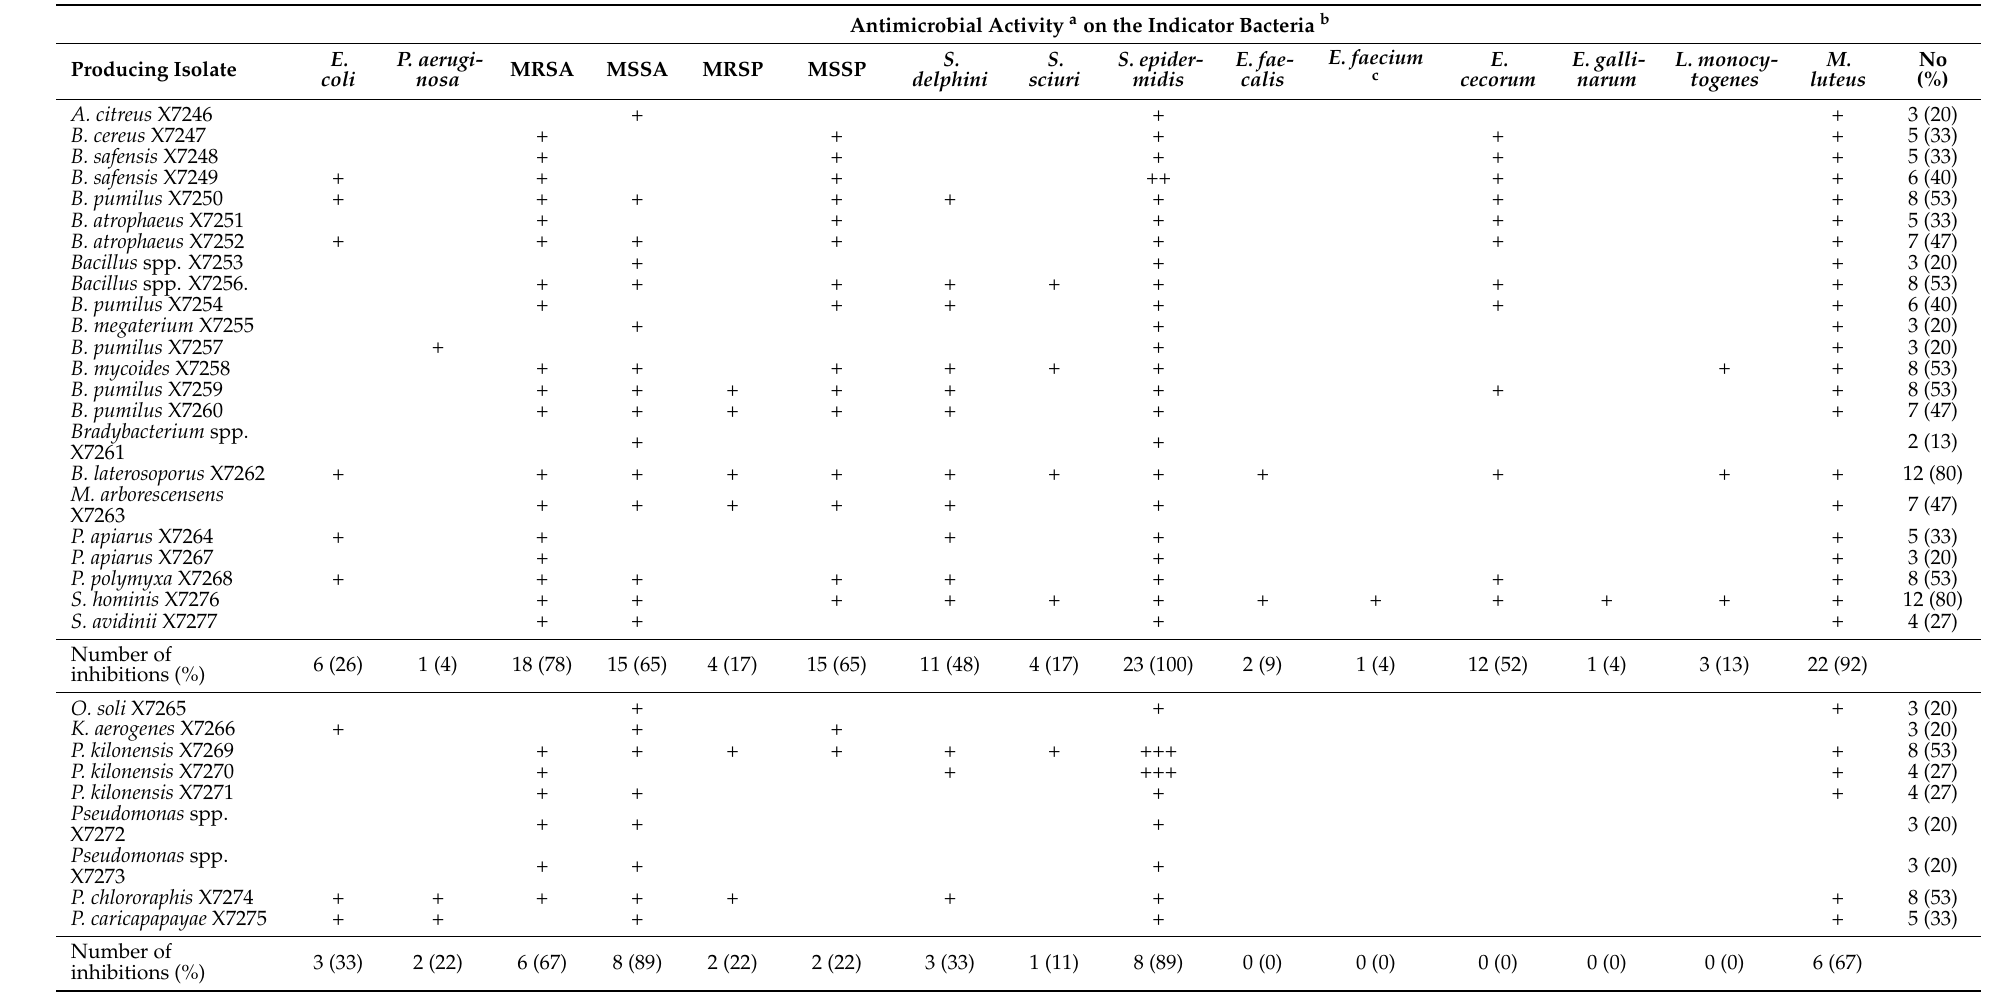
Table 2. Activity profile of the 32 antimicrobial-producing isolates against the 15 indicator bacteria tested. Antimicrobial Activity a on the Indicator Bacteria